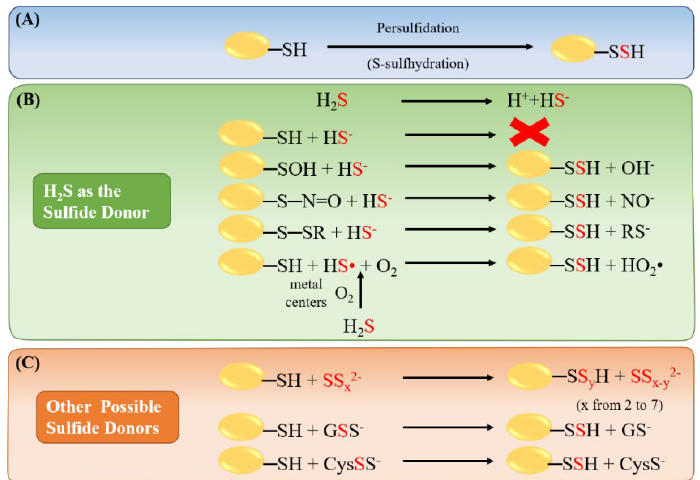
Figure 1. Possible reaction mechanisms for protein persulfidation. ( A ) Illustration of protein persulfidation, also called protein S-sulfhydration. ( B ) Proposed possible persulfidating reaction by H 2 S as the sulfide donor. In solution, H 2 S will dissociate into HS − and H + . A direct reaction between protein thiol and HS - is impossible. In contrast, persulfidation can result from a sulfide anion on an oxidized protein thiol, including S-OH, S-N=O, and S-SR. HS • radical can be generated by H 2 S through oxidation by metal centers. HS • will then react O 2 to generate protein persulfidation and HO 2 • . ( C ) Other sulfide donors, such as polysulfides, glutathione persulfide (GSS - ), and cysteine persulfide (CysSS - ), may also act as persulfidating agents to stimulate protein